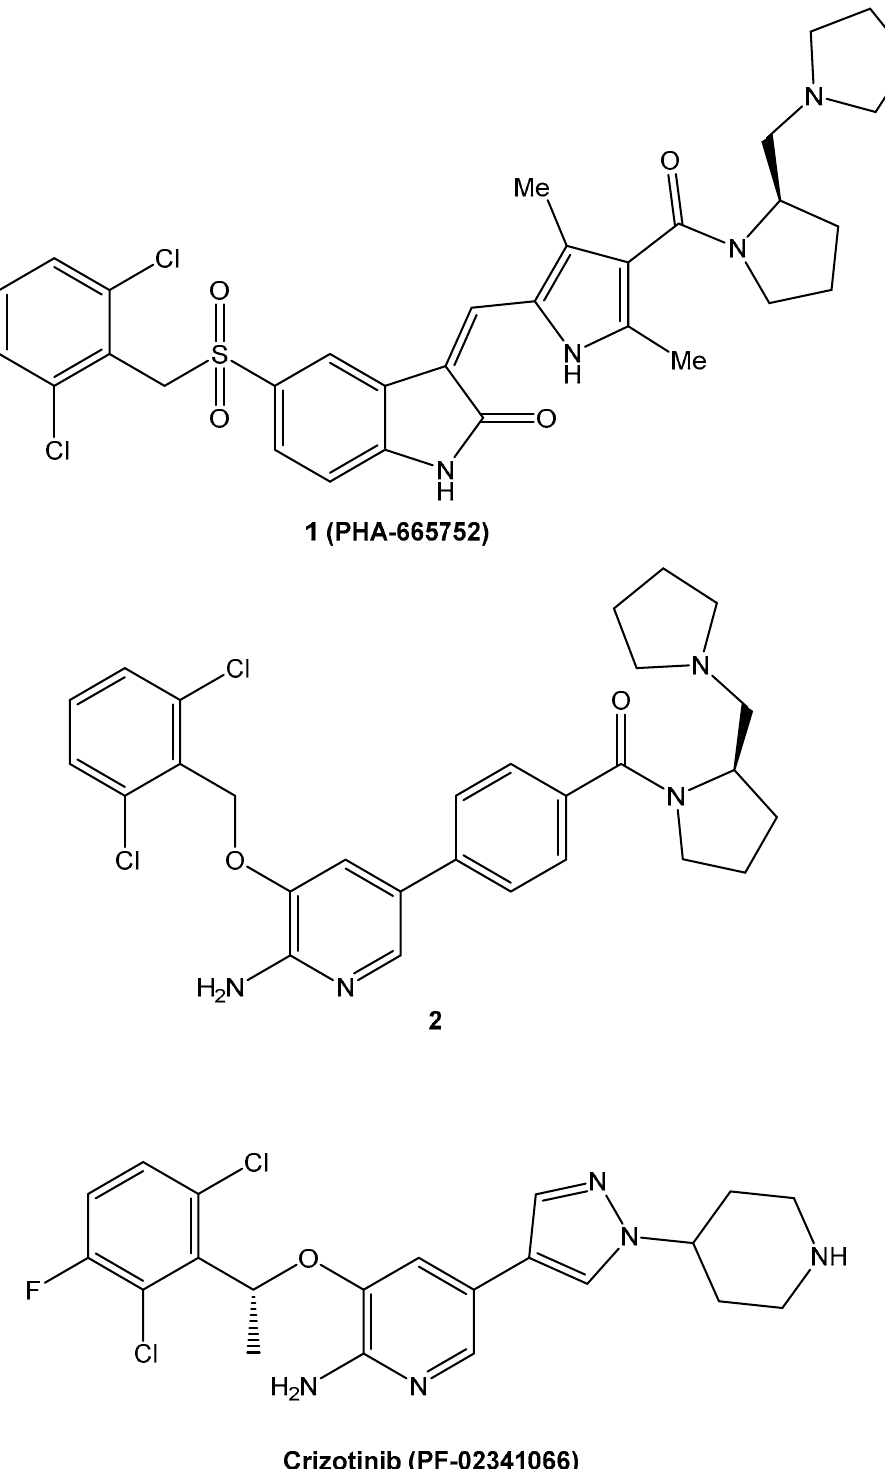
Figure 2. Successful uses of computational tools in the search for anticancer Figure 2 : Successful uses of computational tools in the search for anticancer drugs.